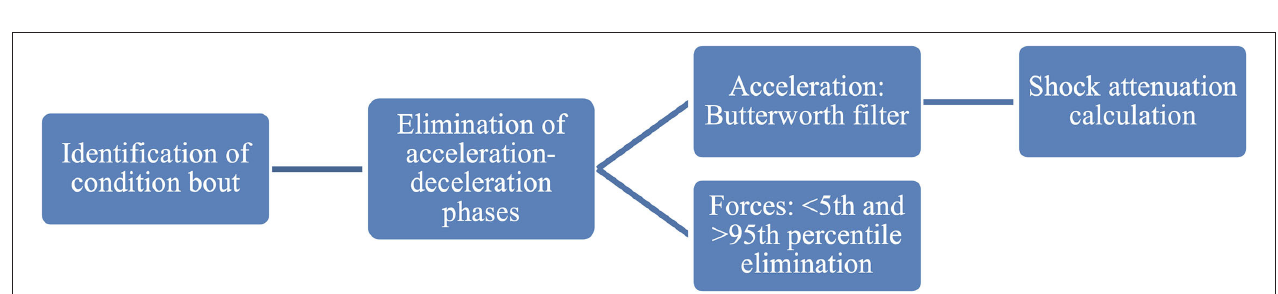
FIGURE 3 | Boxplots of C7: sacrum and helmet: saddle shock attenuation waves before and after the coaching and feedback interventions at trot and canter. *Significant time interaction; † significant group interaction.